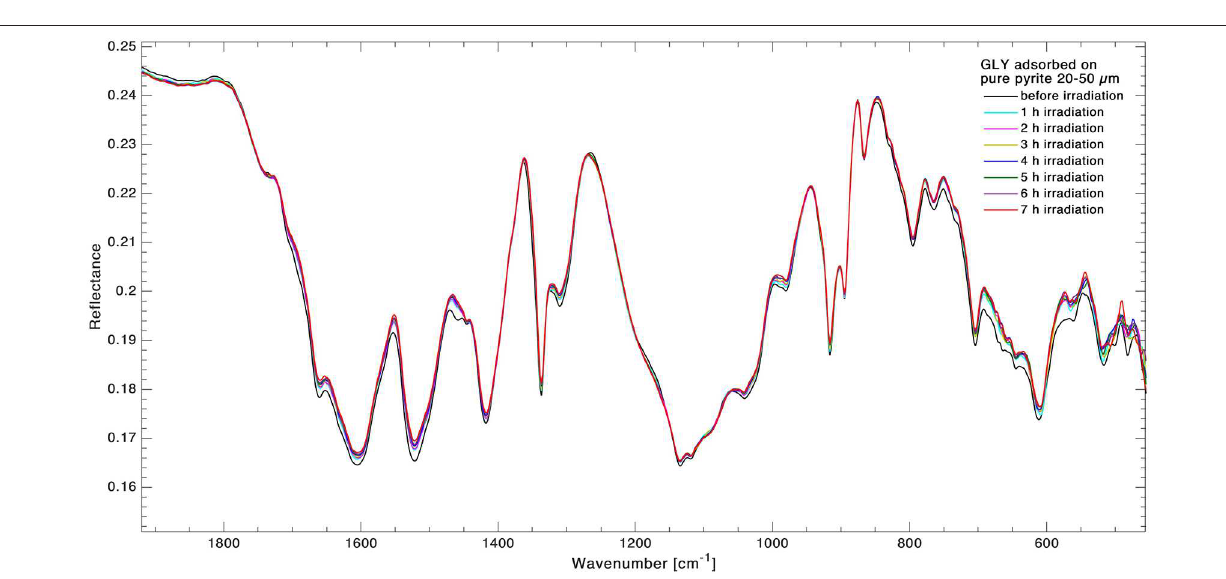
∝ − β t . This formula is more suitable kinetics: ln h N ( t ) N 0 i